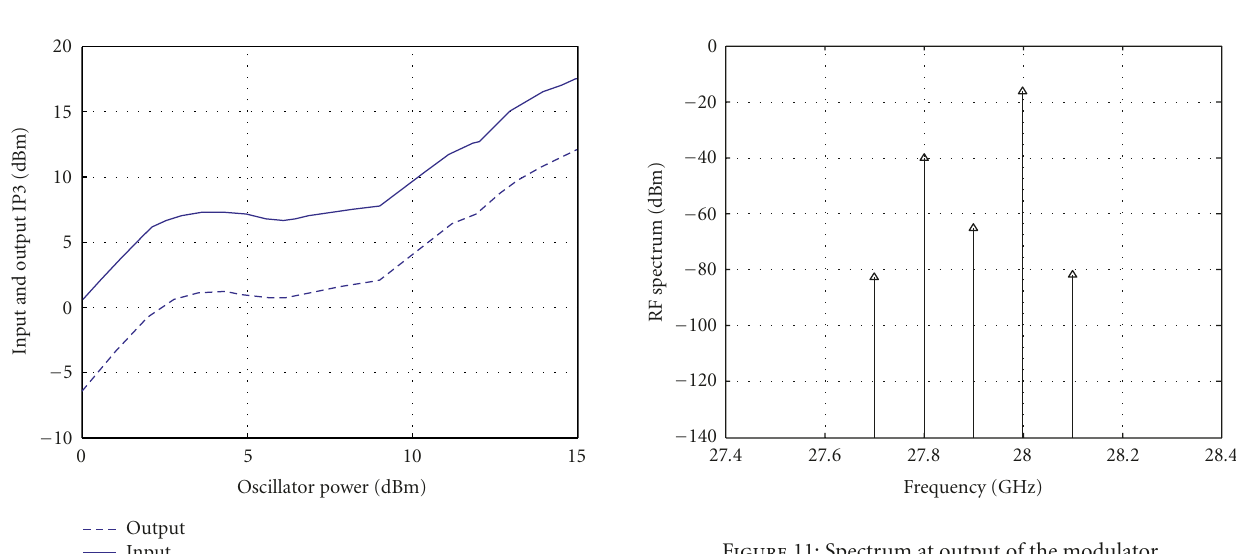
Figure 11: Spectrum at output of the